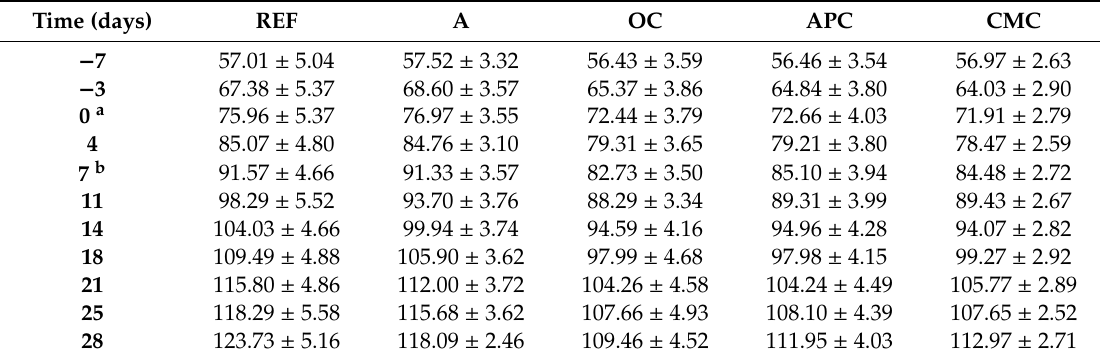
Table 2. Body weight for all experimental groups throughout the study. REF: healthy reference group fed standard diet; A: asthmatic group fed standard diet; OC: asthmatic group fed 10% ordinary Peruvian cocoa; APC: asthmatic group fed 10% “Amazonas Peru” cocoa; CMC: asthmatic group fed